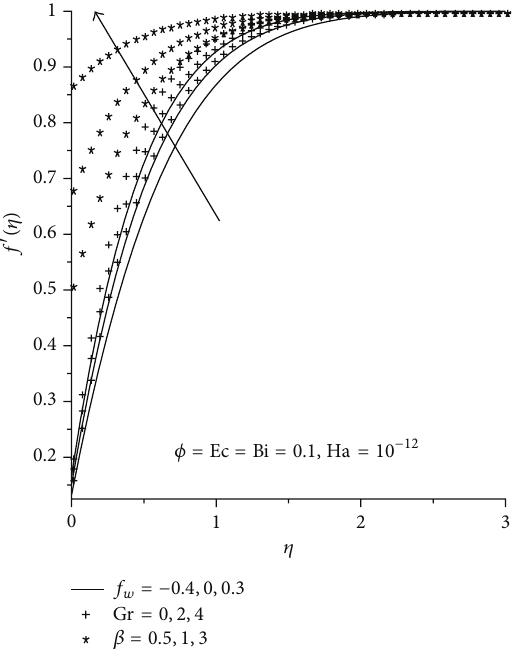
Figure 4: Velocity profiles with increasing Gr, 𝛽 , and 𝑓 𝑤 . Figure 5: Temperature profiles for different nanofluids.